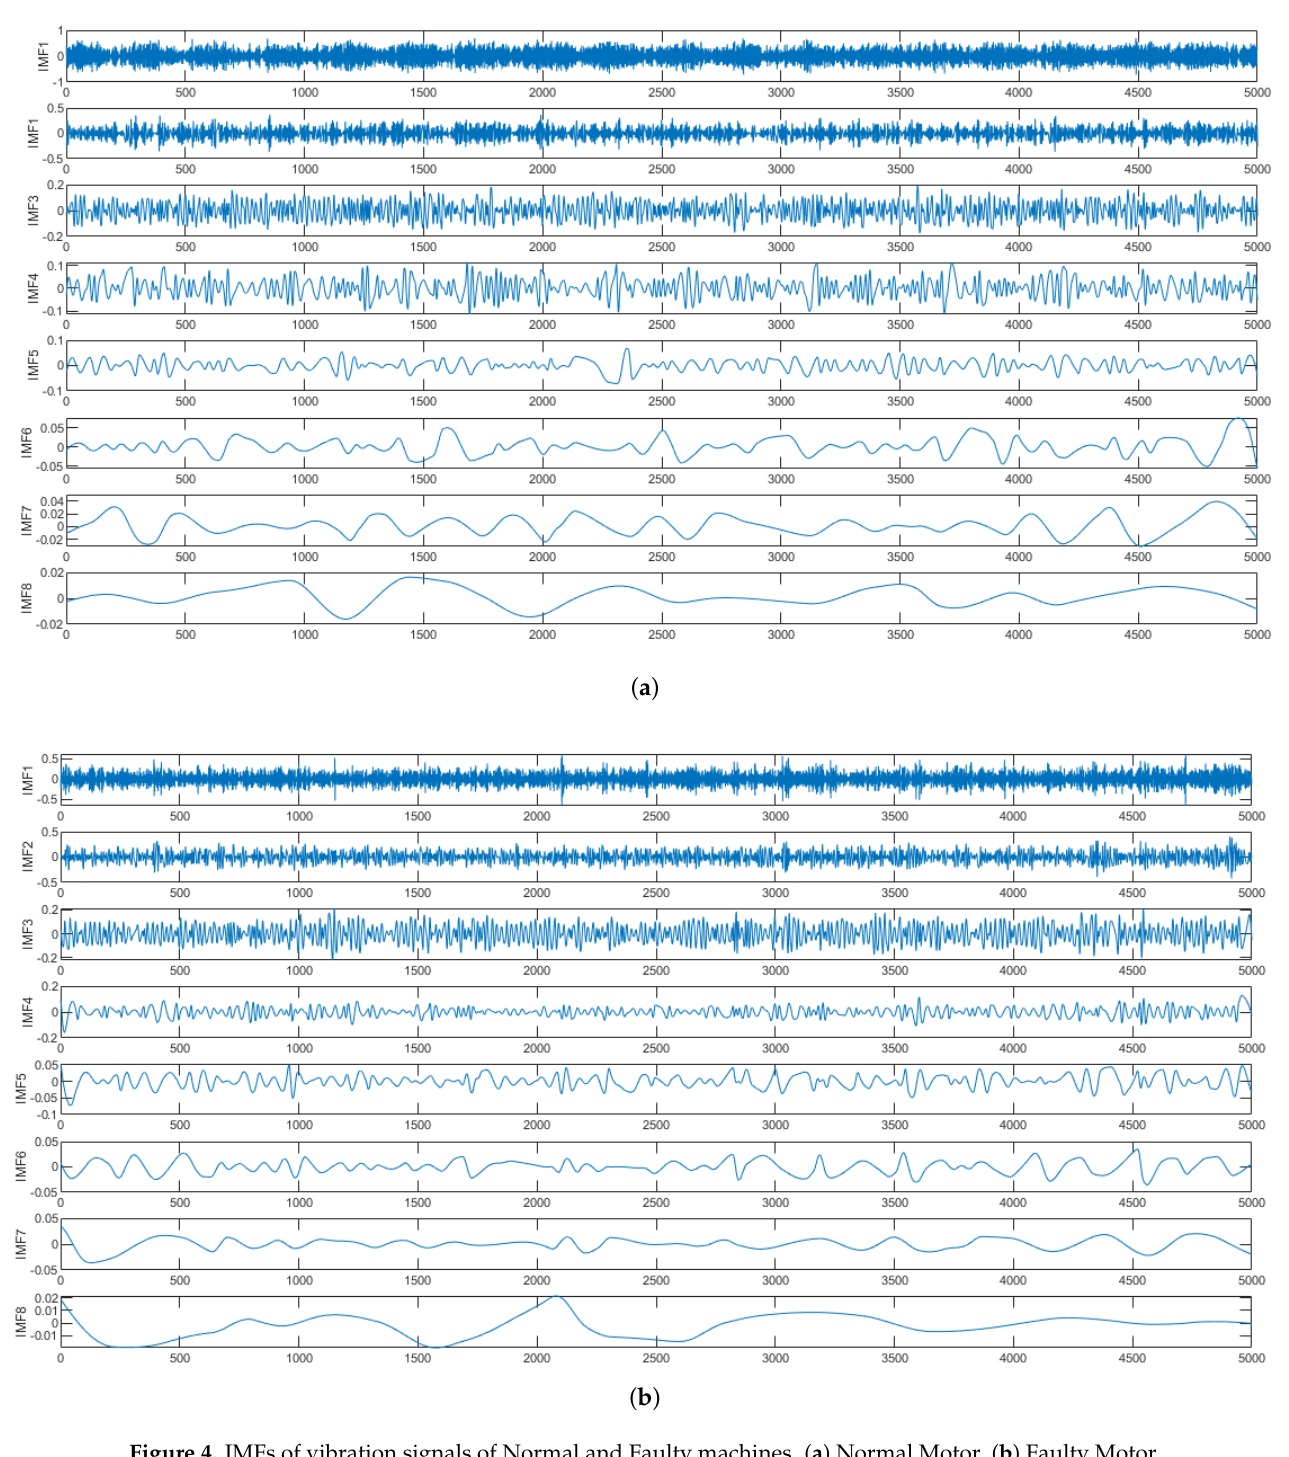
Figure 4. IMFs of vibration signals of Normal and Faulty machines. ( a ) Normal Motor. ( b ) Faulty